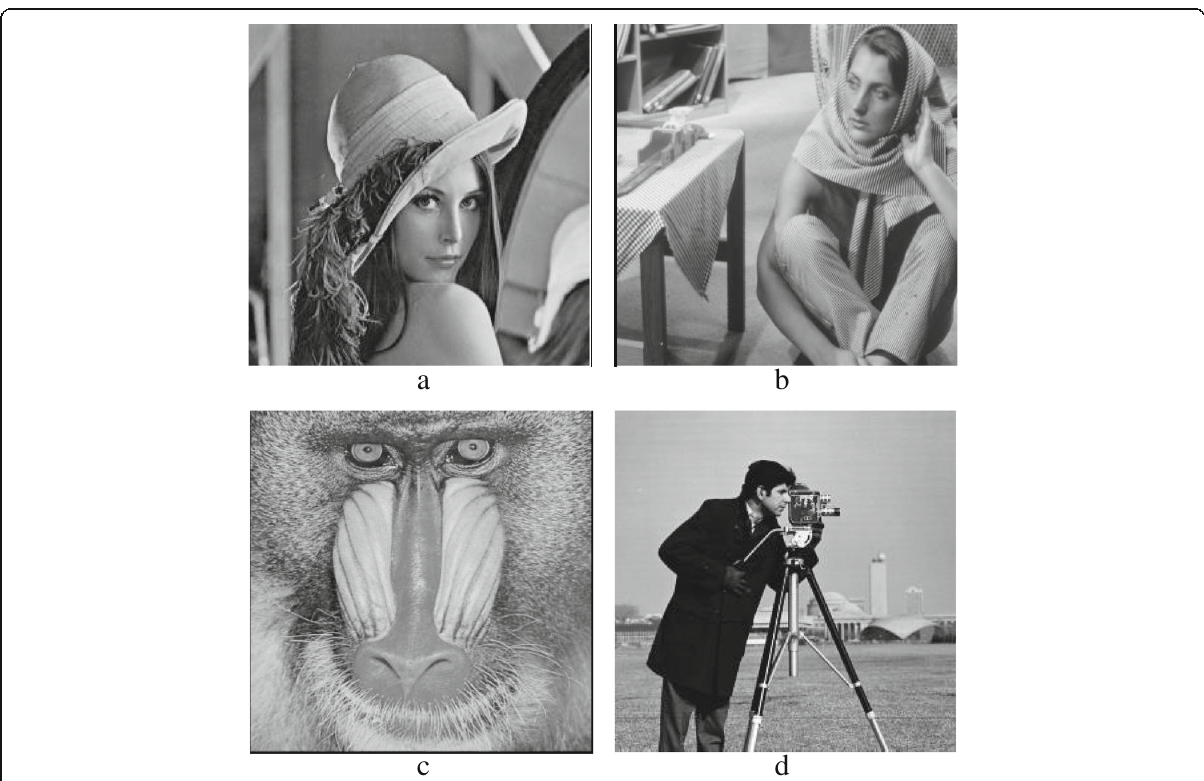
Fig. 1 Original images for experiments. a Lena image. b Women image. c Baboon image. d Cameraman image